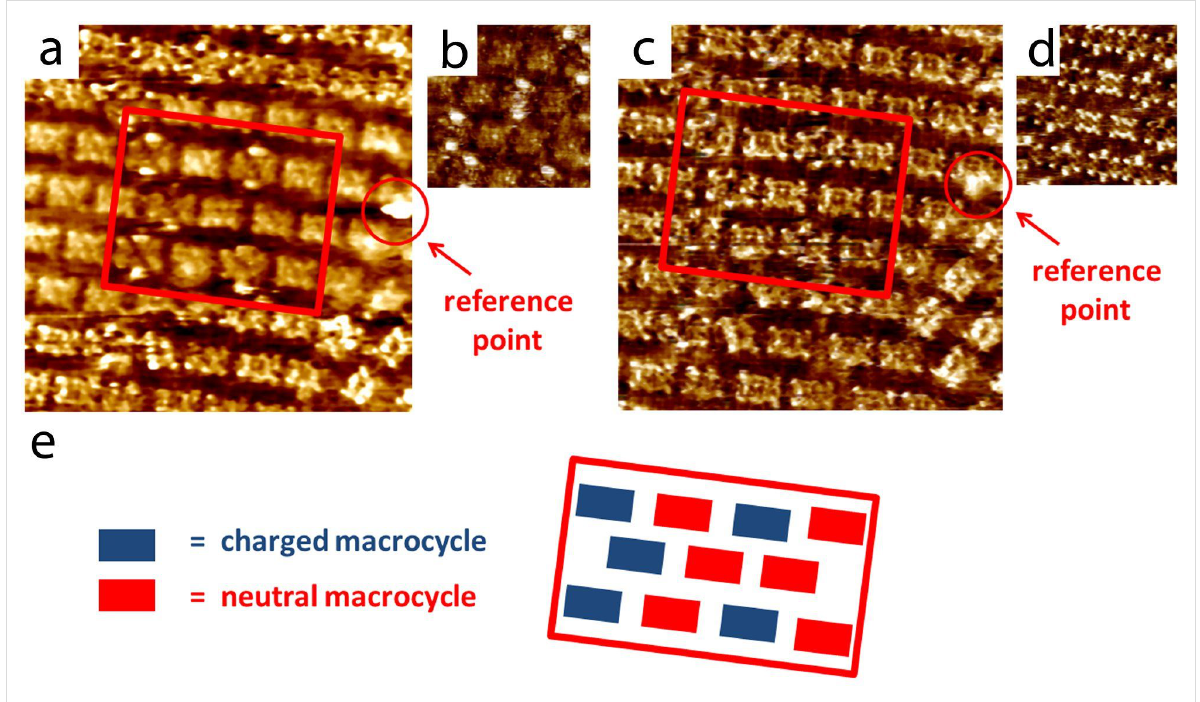
Figure 4: Assignment of STM contrasts to macrocycle 1 and 2 ; a) 31 nm x 31 nm, i T = 36 pA, V S = − 554 mV. STM images (a) and (c) were recorded at the same location on the HOPG surface. A bright spot highlighted by the red circle acts as a reference point. b) A typical high resolution STM image (18.1 nm × 18.1 nm, i T = 37 pA, V S = − 561 mV) smoothened by 3-point median processing [30] in order to decrease the noise level and highlight the localisation of the iodide counterions. c) STM image of the same area as in Figure 4a scanned at higher tunnelling current, 29 nm x 29 nm, i T = 67 pA, V S = − 554 mV. d) A typical high resolution STM image (17.2 nm × 17.2 nm, i T = 45 pA, V S = − 554 mV) showing the internal structure of the macro- cyclic backbone. e) Schematic representation of the composition of the scanned area highlighted in Figure 4a and